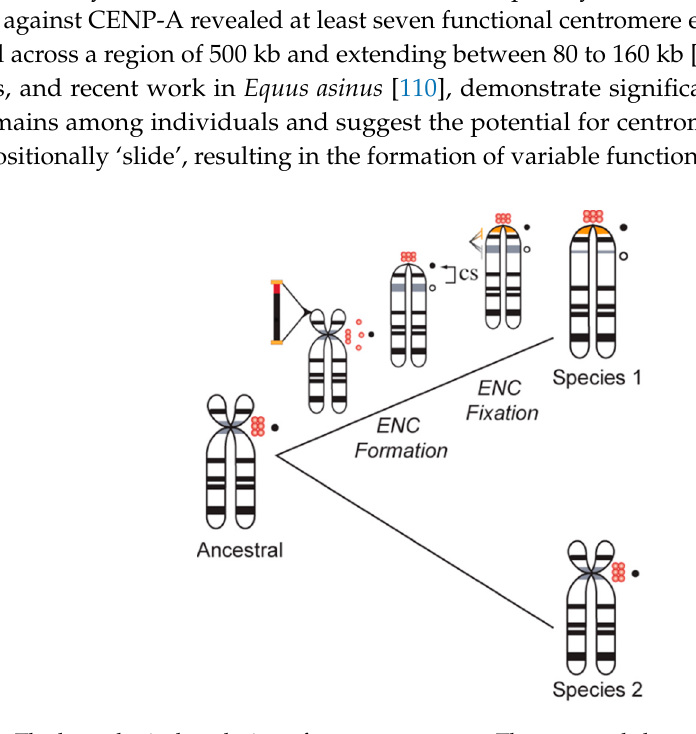
Figure 4. The hypothetical evolution of new centromeres. The ancestral chromosome in this example is submetacentric (the centromere is indicated with red ‘nucleosomes’). The active locus (black dot) carries satellite arrays. Some individual(s) in a population experience the destabilization of the active centromere and formation of a neocentromere, perhaps through the activation of a new TE, resulting in a centric shift (CS). The new centromere is indicated with a black dot, while the latent centromere is indicated with an open circle. The new centromere becomes fixed in a population and eventually gains new satellite arrays (orange), either by interchromosomal seeding from the old centromere (grey) or from the TE itself. Over time, the latent centromere loses its HORs while the new centromere becomes stabilized. In some cases, the ENC can lead to a new species karyotype.